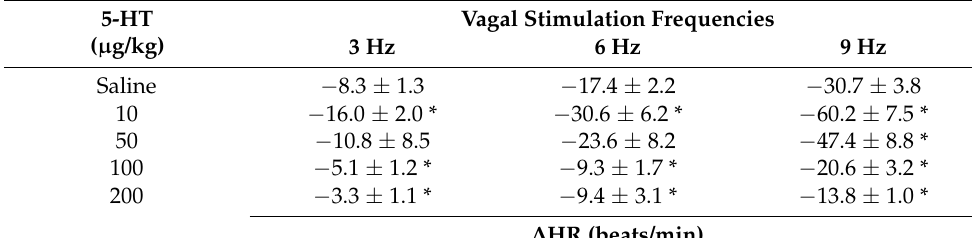
Table 2. Effect of 5-HT on the electrically-induced bradycardia in fluoxetine-treated diabetic rats. 5-HT ( µ